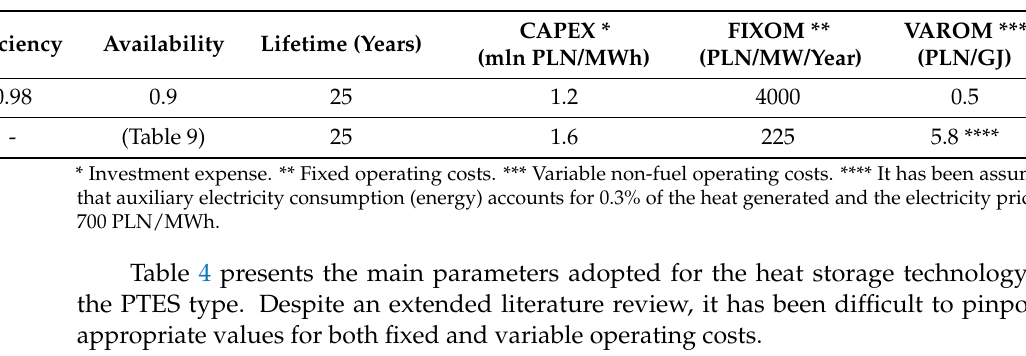
Table 3. Data of heat generation technology.